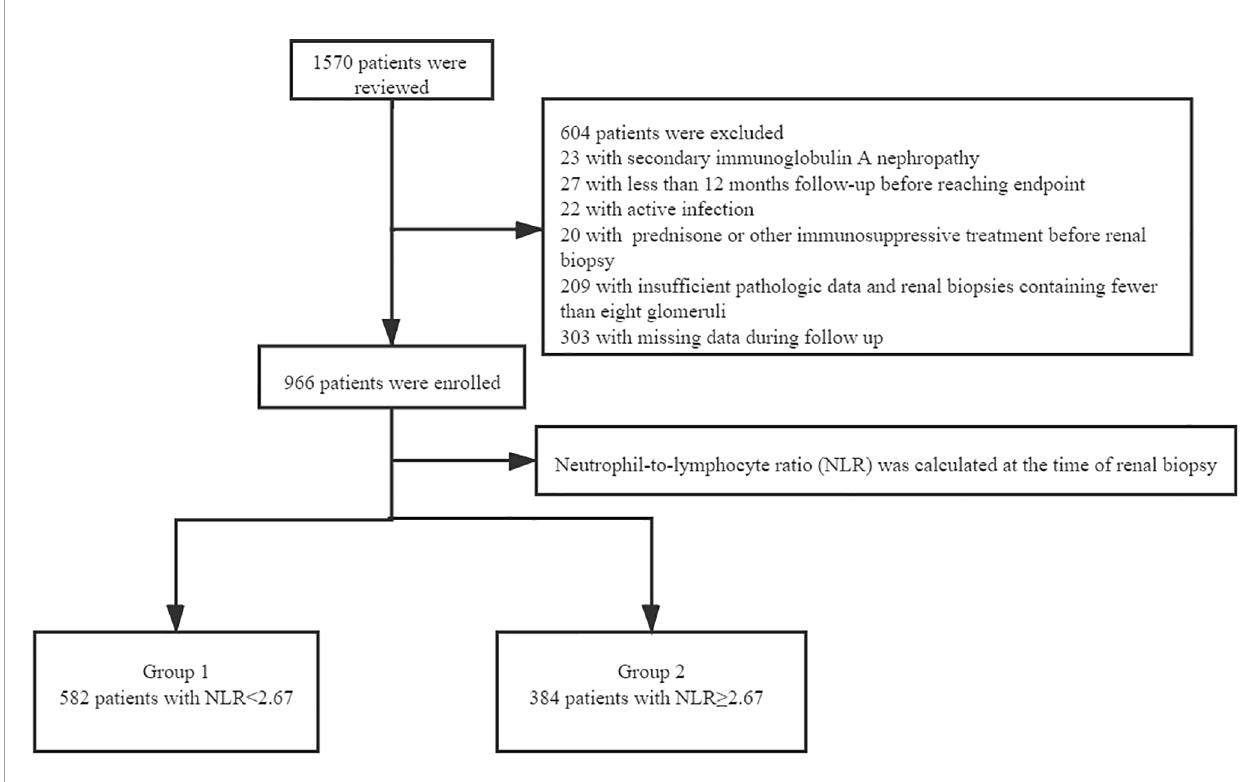
FIGURE 1 | The fl ow chart of excluded